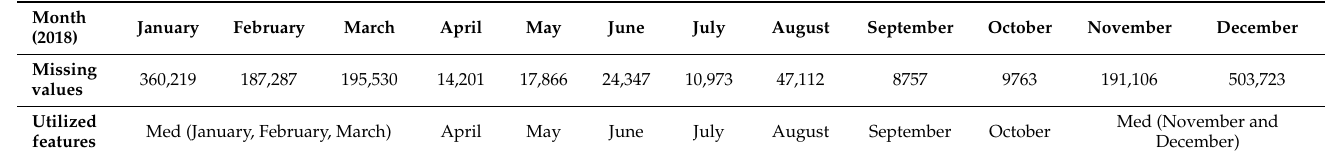
Table 4. The number of samples with missing values for each monthly feature. “Med” indicates the median